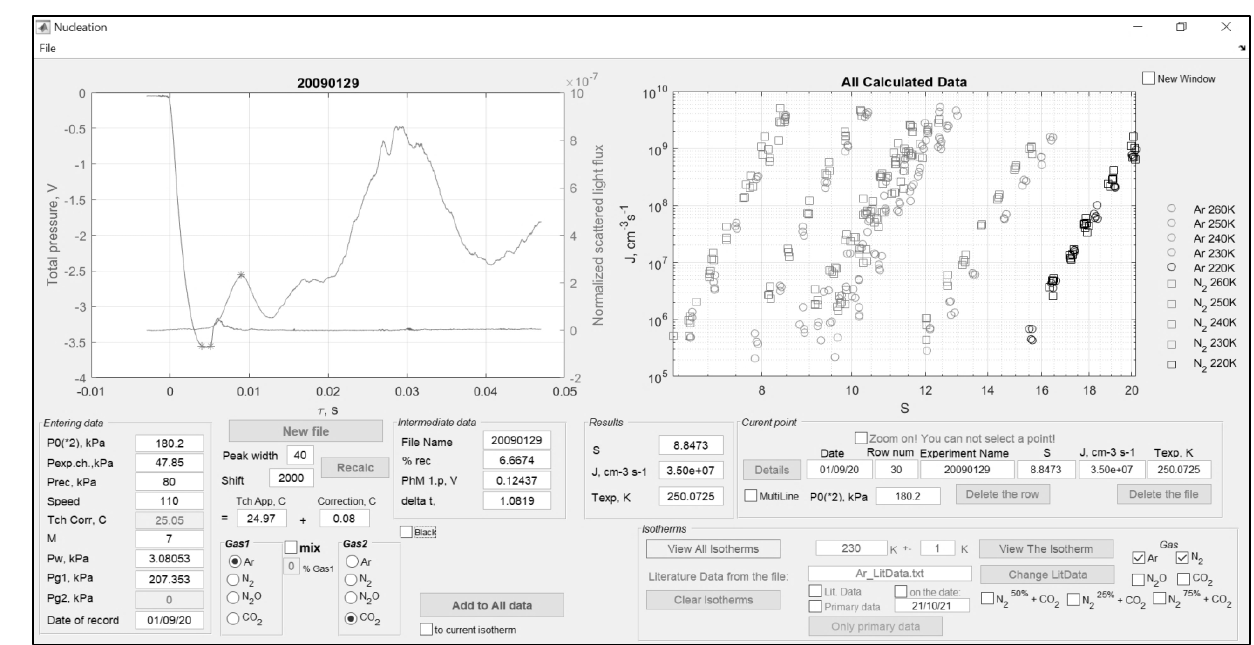
Fig. 2 . The interface of the program for data processing